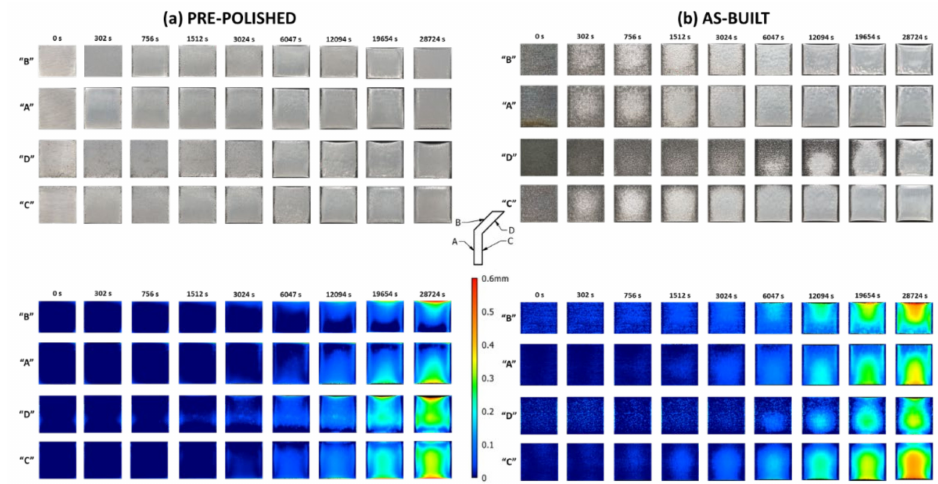
Figure 13. V-shape artifact MR results (3D microscope): ( a ) pre-polished; ( b ) as-built.